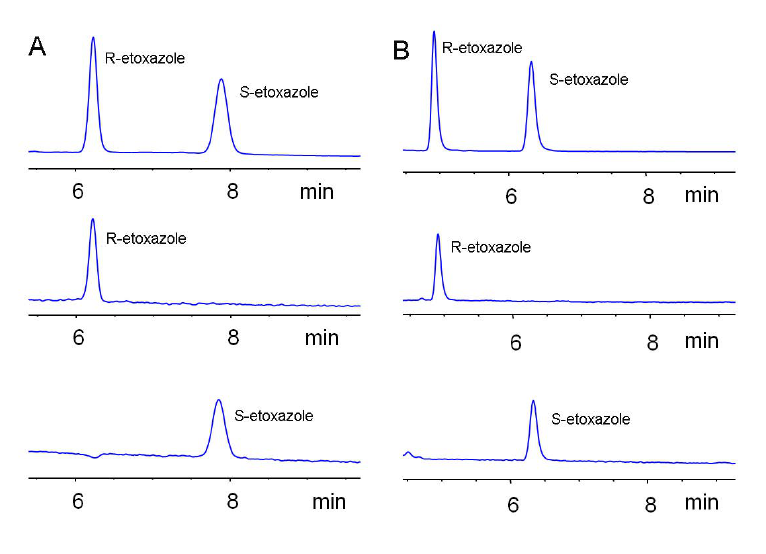
Figure 4. Eluted order of etoxazole enantiomers on ( A ) Lux Cellulose-3 column (acetonitrile / water, 70 / 30) and ( B ) Chirapak IC (acetonitrile / water, 80 /